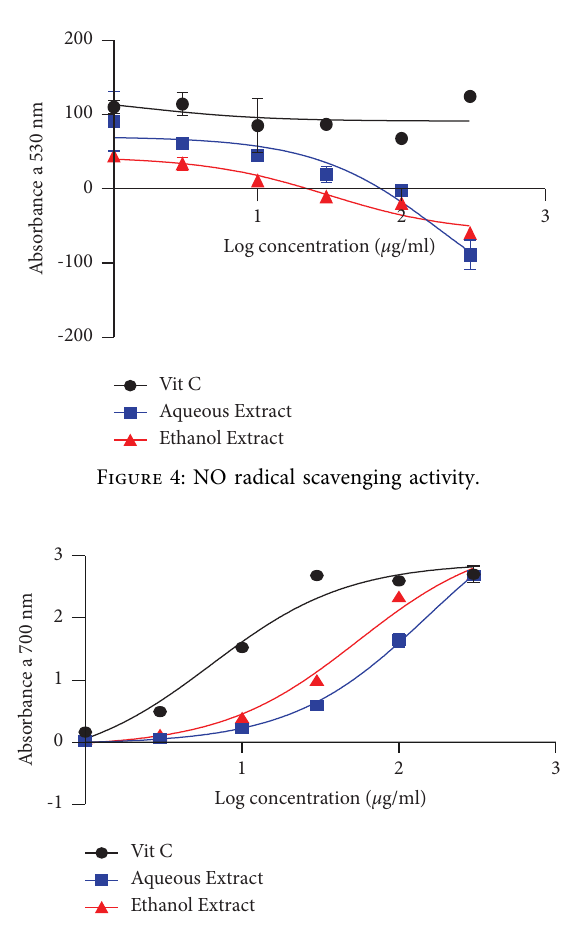
Figure 5: Ferric-reducing power of L. lanceolata